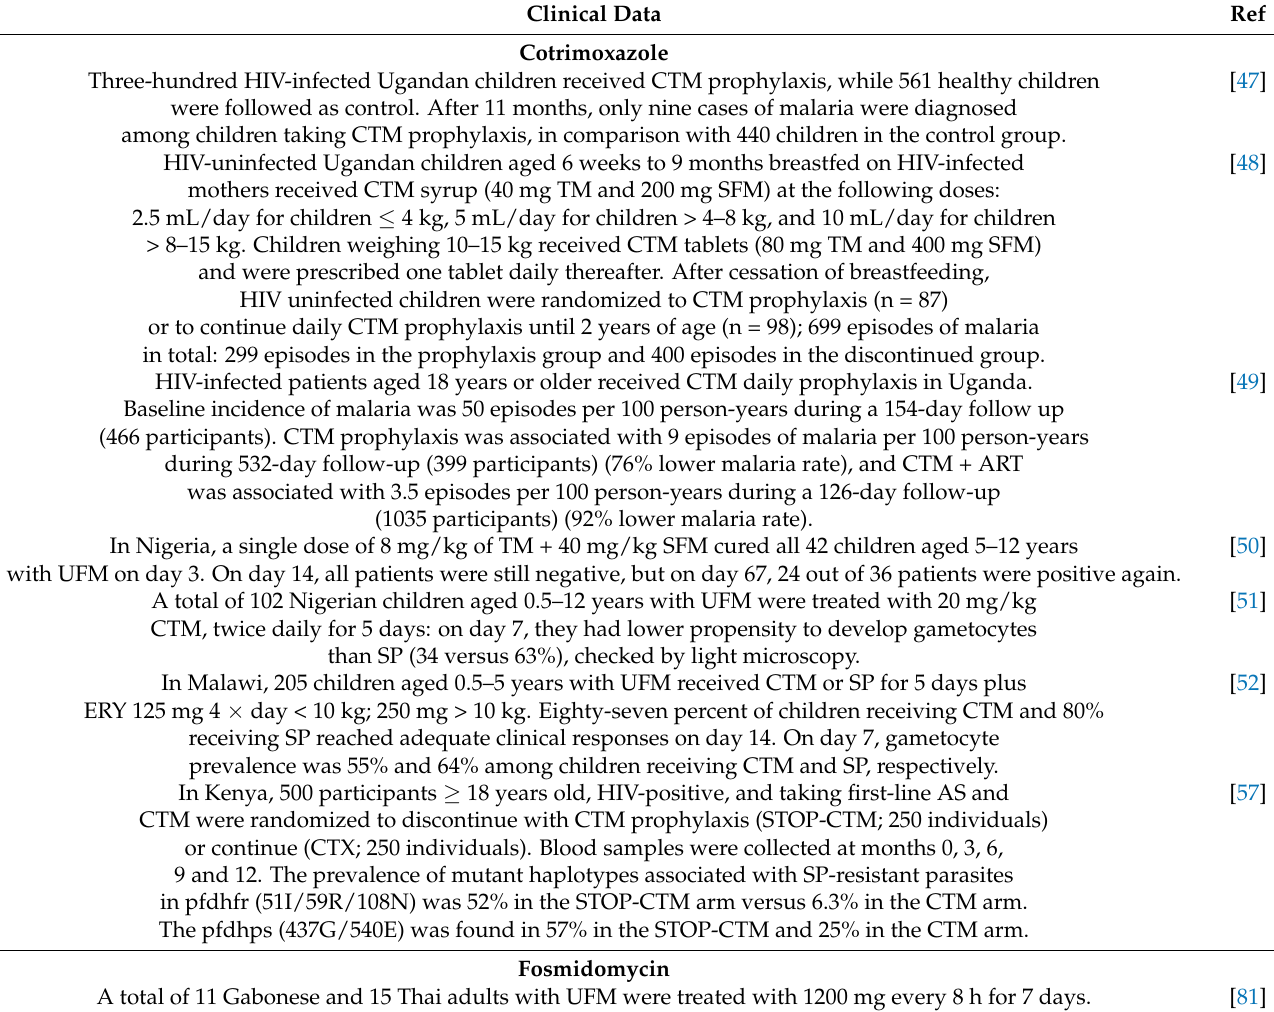
Table 2. Summary of the clinical data of fast-acting antibiotics to treat malaria in humans. Clinical Data Ref